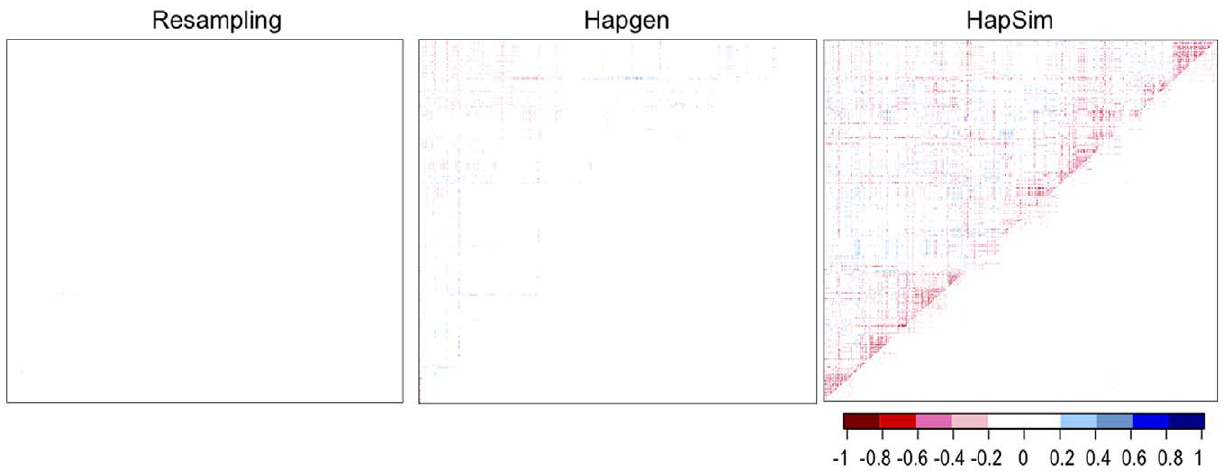
Figure 5. Heat maps of change in median LD for Gene Region 2. Heat maps of change in median simulated LD from original LD in Gene Region 2 (median[LD simulated ] – LD HapMap ). Upper left D’, lower right r 2 . Blue indicates a gain in LD; red indicates a loss in LD.